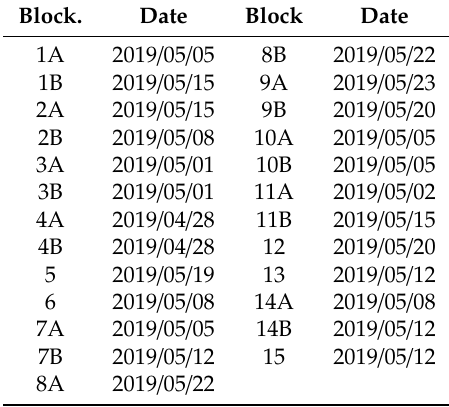
Table 1. Block values of transplanting date at the test site (first crop in the dry season of 2019). Dates are in YYYY / MM / DD format.